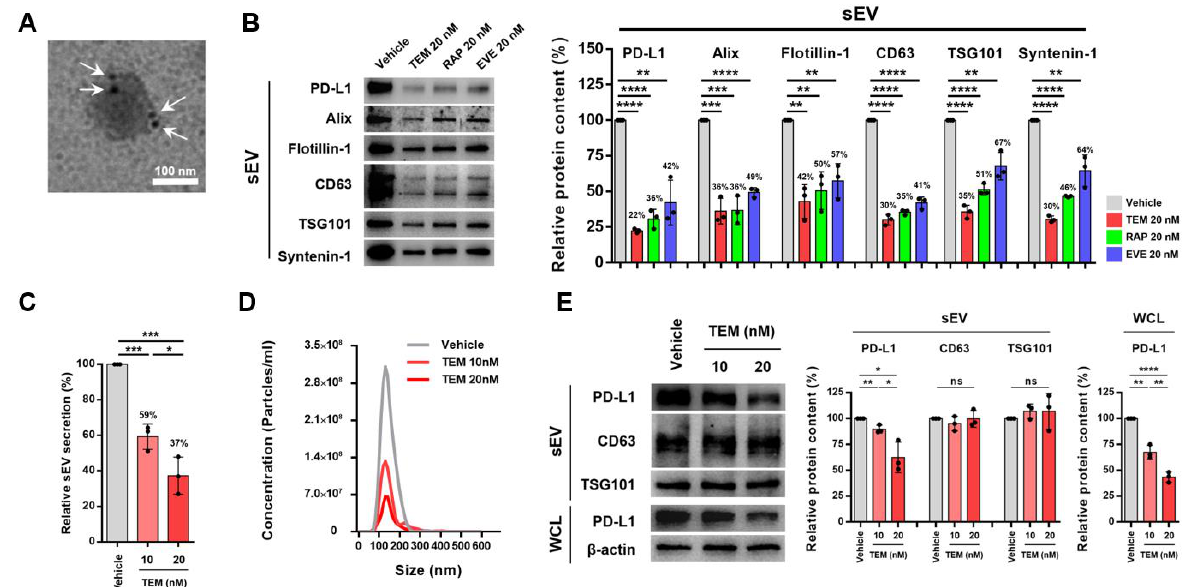
Figure 1. Temsirolimus (TEM) suppresses sEV PD-L1 through the inhibition of small extracellular vesicle (sEV) secretion and cellular PD-L1 level. ( A ) A transmission electron microscopy image of MDA-MB-231-derived sEVs conjugated with immunogold-labeled PD-L1 antibodies. Arrowheads indicate 5 nm gold particles. Scale bar, 100 nm. ( B ) The immunoblots of various proteins in sEV from MDA-MB-231 with or without treatment of mTOR inhibitors ( left ) ( n = 3). sEV proteins from approximately 1.2 × 10 7 cells were loaded per lane. The quantitative analysis of the relative protein expression ( right ). ( C ) The relative percentage of secreted sEV from MDA-MB-231 cells with or without treatment of TEM by nanoparticle tracking analysis (NTA) ( n = 3). ( D ) A representative graph of the size distribution of secreted sEV from MDA-MB-231 cells with or without treatment of TEM. ( E ) Immunoblots of various proteins in sEV and whole cell lysate (WCL) from MDA-MB-231 cells with or without treatment of TEM ( left ) ( n = 3). An equal protein weight (3 µ g) of the sEV was loaded per lane. β -actin was used as the loading control. The quantitative analysis of the relative protein expression ( right ). The data are presented as means ± standard deviation (SD) using an unpaired two-tailed Student’s t -test. * p < 0.05, ** p < 0.01, *** p < 0.001, and **** p < 0.0001, respectively; ns, not